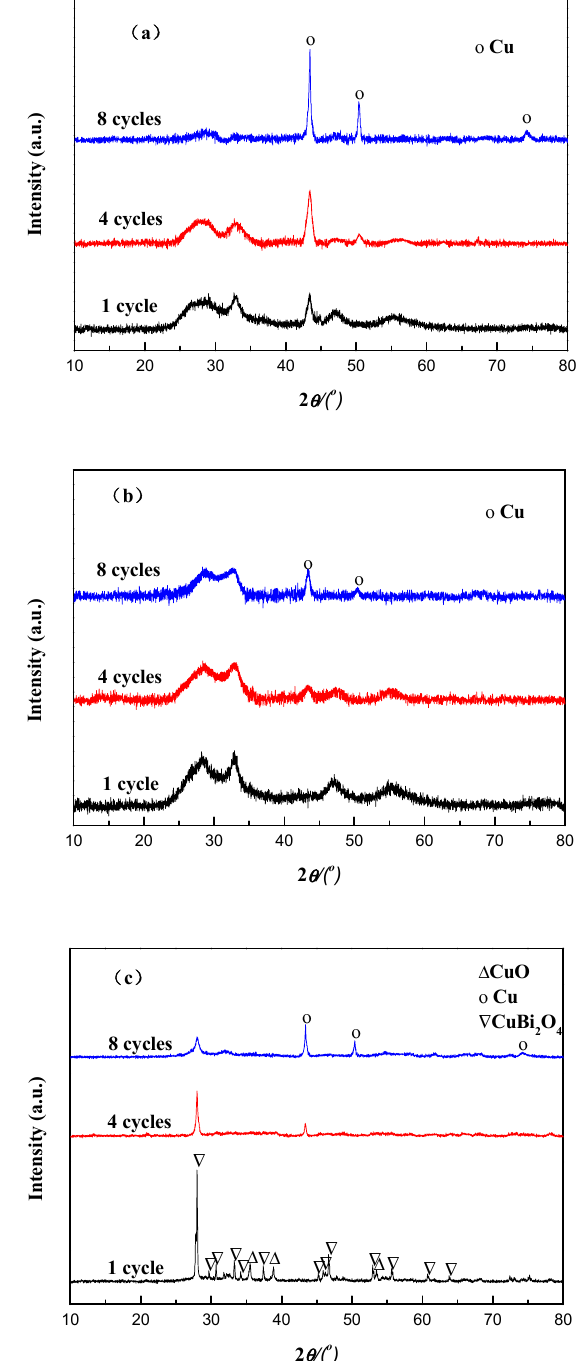
Figure 12. XRD patterns of the ( a ) CB-500, ( b ) CB-600, ( c ) CB-700 catalysts after 1, 4 and 8 recycles evaluation.